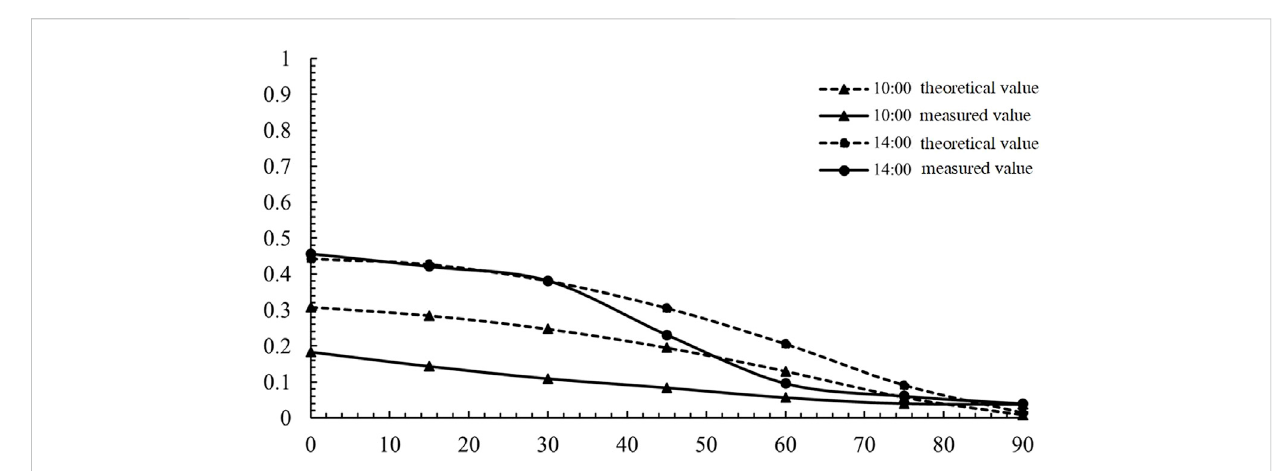
FIGURE 7 Comparison of theoretical and measured transmittance values of blind with different slat inclination angles.